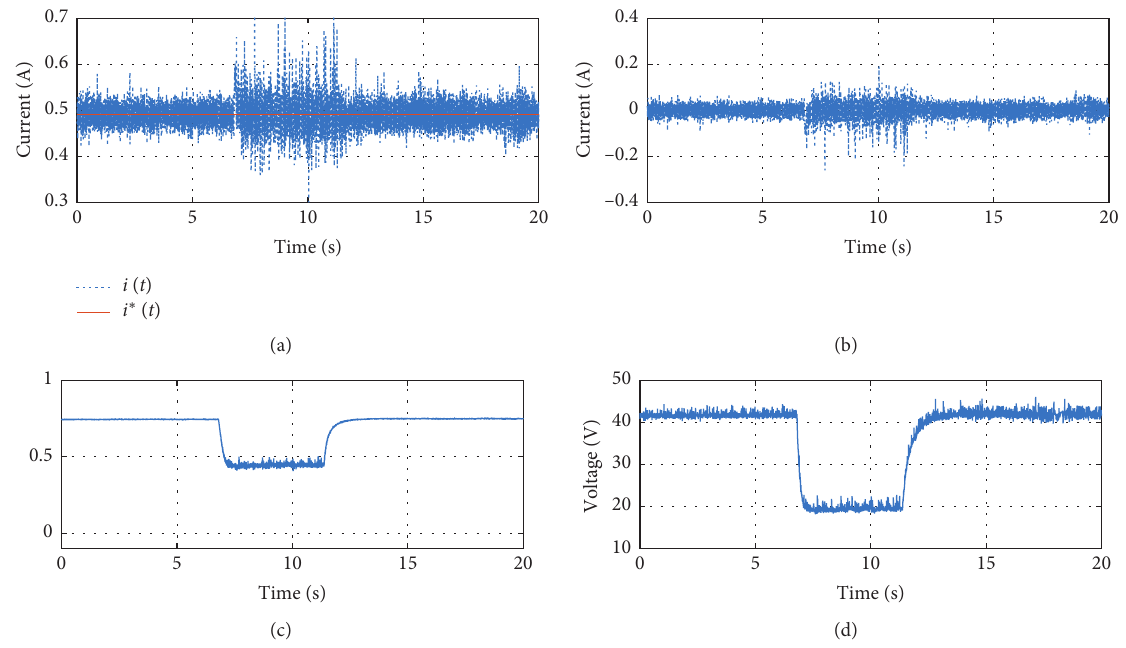
Figure 17: Boost converter response to disturbances, SSTA controller. (a) Desired current and measured current. (b) Error. (c) Control action. (d) Output voltage.